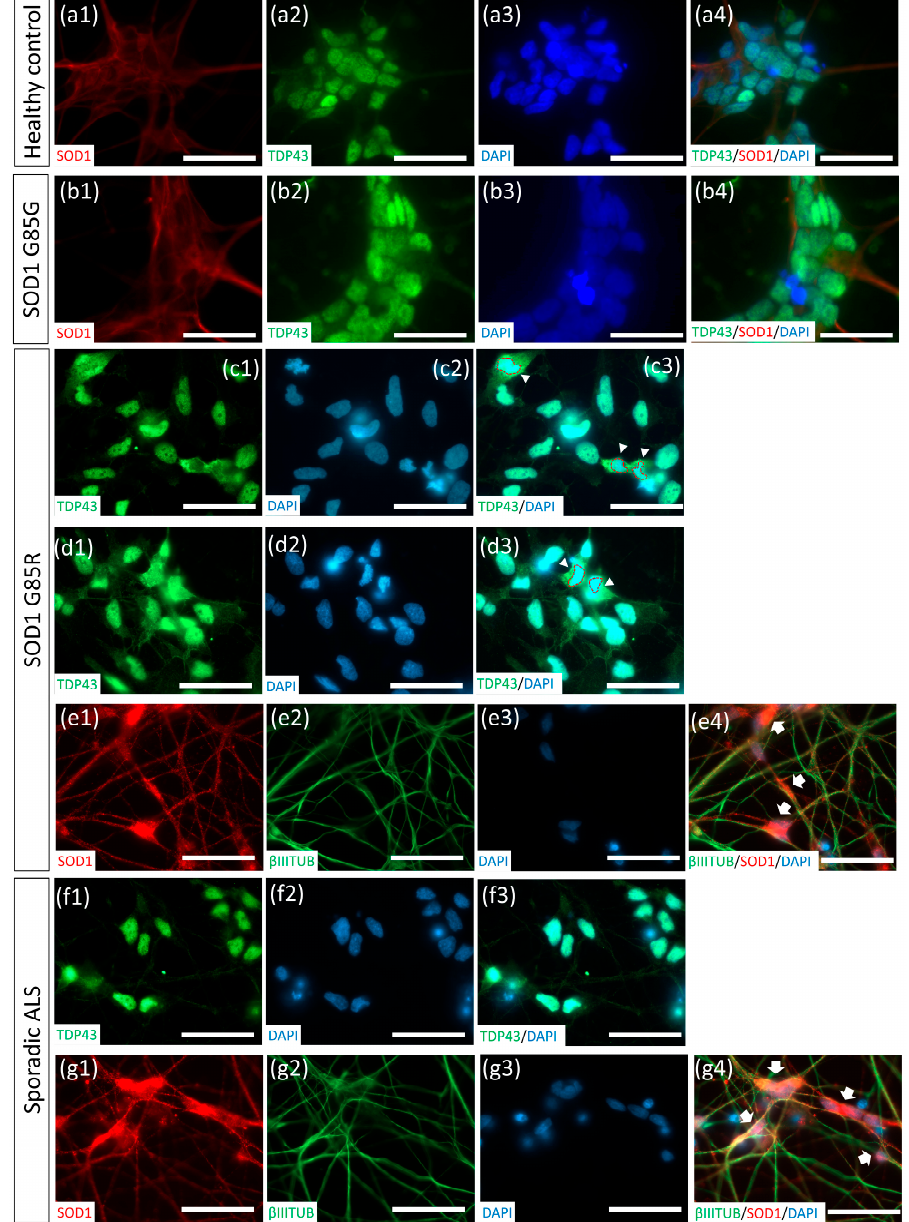
Figure 6. Misfolded SOD1 accumulation and cytosolic TDP-43 distribution cytopathies in SOD1 G85R and sporadic ALS MNs. ( a – g ) SOD1 and TDP-43 expressions in DAPI + cells from healthy hESC- derived MNs ( a ), SOD1 G85G MNs ( b ), SOD1 G85R MNs ( c – e ), and sporadic ALS MNs ( f – g ). The cell nuclei are indicated by red circles and cytosolic TDP-43 is indicated by arrowheads in ( c , d ), respectively. Accumulated misfolded SOD1 is indicated by arrows in ( e , g ). Number 1 − 3 presenting the separated images and number 4 presenting merged images in ( a − g ). Scale bar, 100 µ